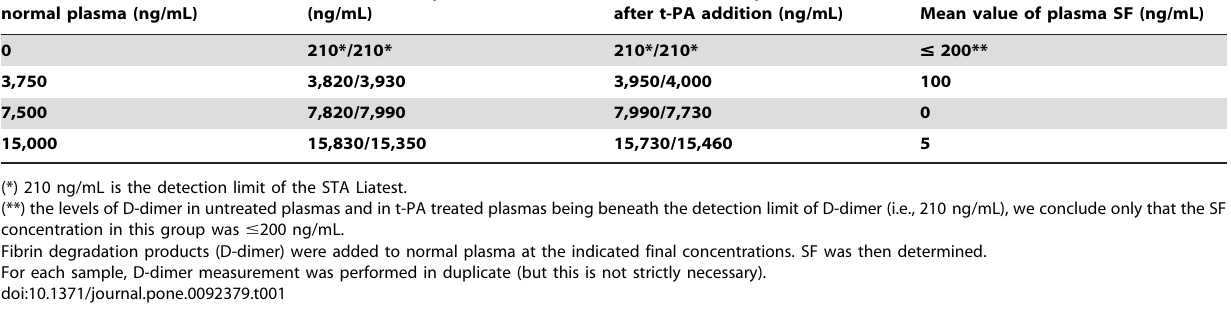
Basal value of plasma D-dimer